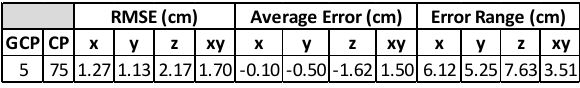
Table 2. UAV Orthomosaic and DSM accuracy statistics based on 75 checkpoints.